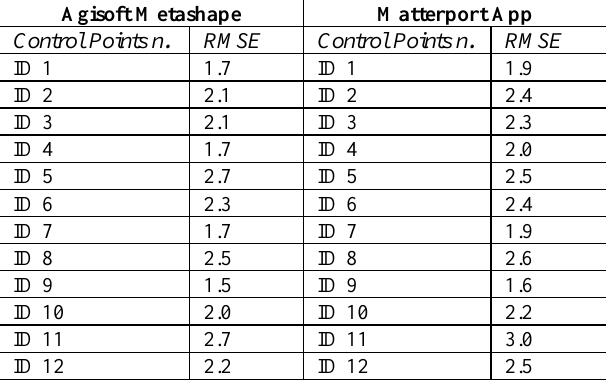
Table 3 . RMSE statistics (in cm) after adding control points in the adjustment.